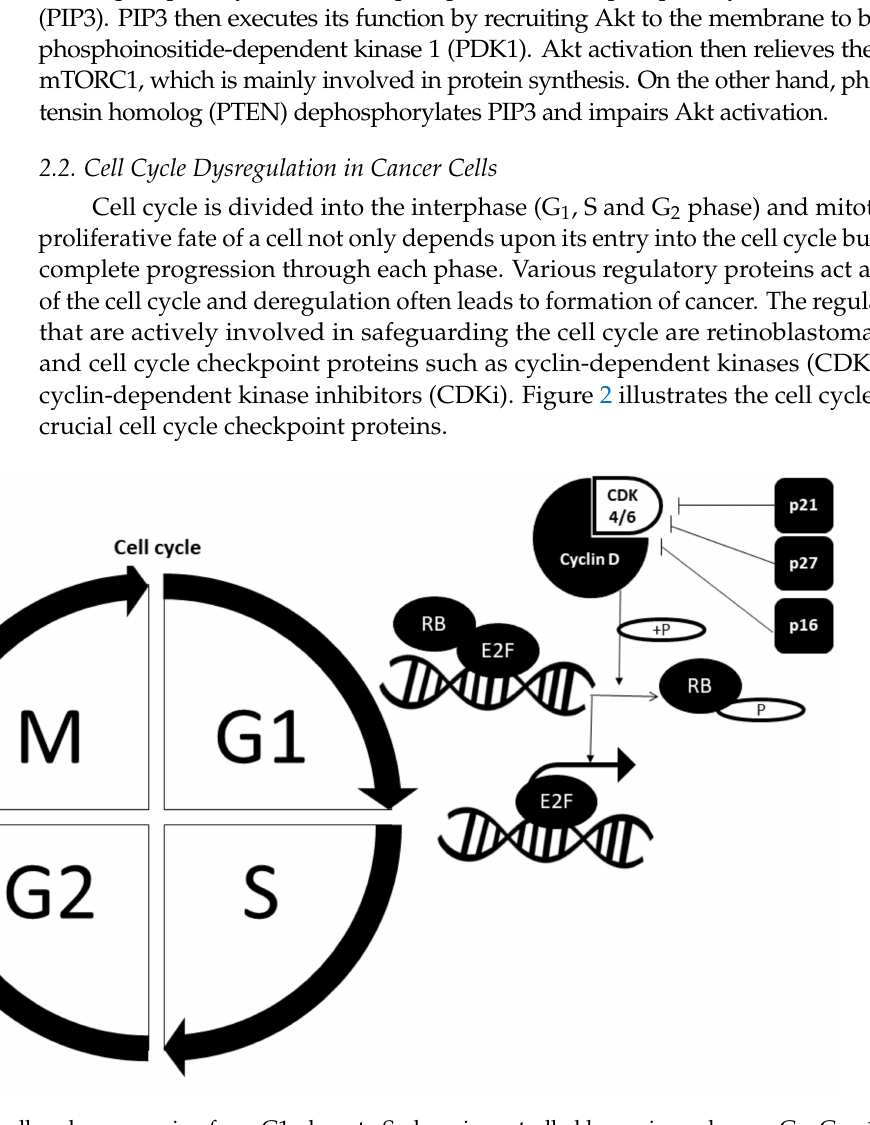
Figure 2. Regulation of cell cycle progression from G1 phase to S phase is controlled by various players. G 1 : Gap 1 phase; S: Synthesis phase; G 2 : Gap 2 phase: M: Mitotic phase; RB: Retinoblastoma; E2F: CDK: Cyclin-dependent kinase; P: Phosphate